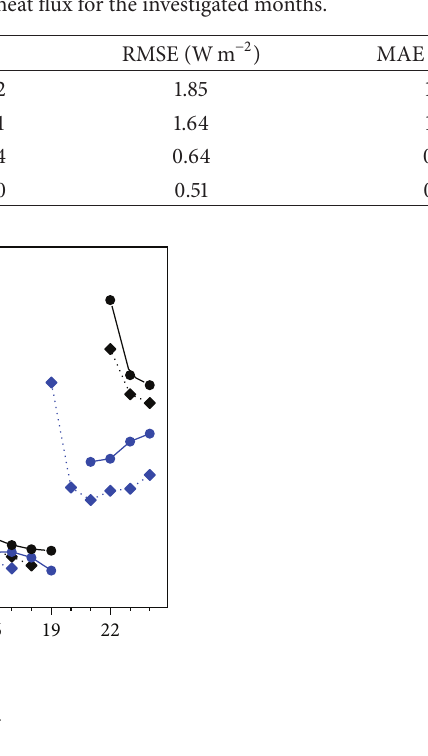
Figure 6: Diurnal variation of hourly average fraction of soil heat flux ( 𝐺 ) as a percentage of net radiation ( 𝑅 𝑛 ) for December 2013 to March 2014. Data for the transitional periods were removed from the